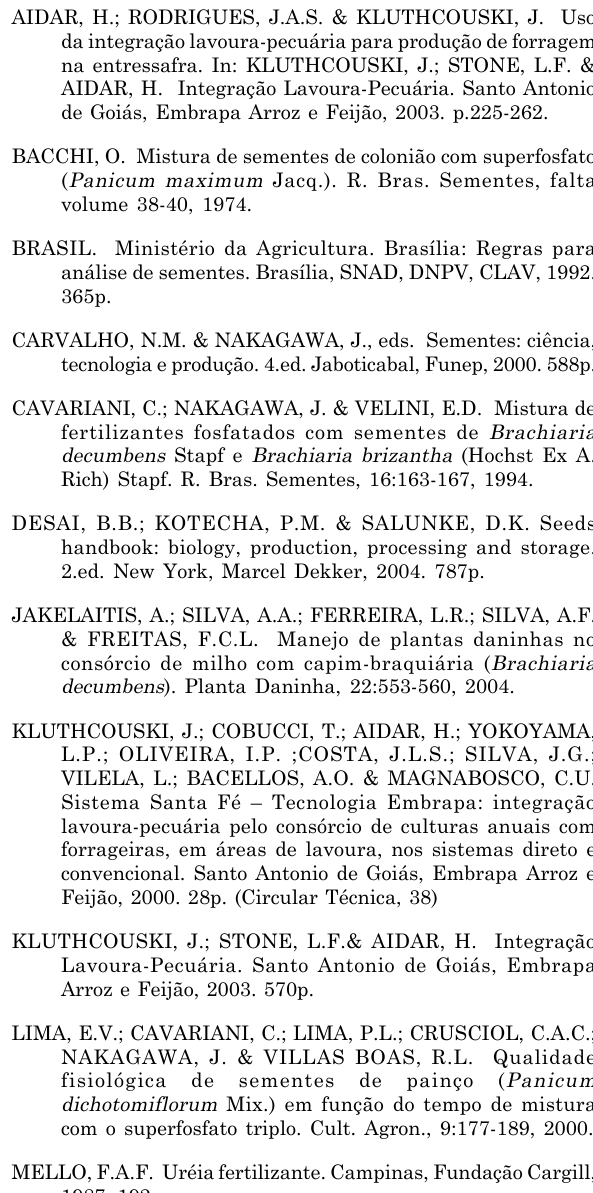
Figura 4. Germinação de sementes de Brachiaria brizantha em razão do período de contato com formulado granulado ( ) e formulado farelado ( ), em condições de laboratório (a) e no solo